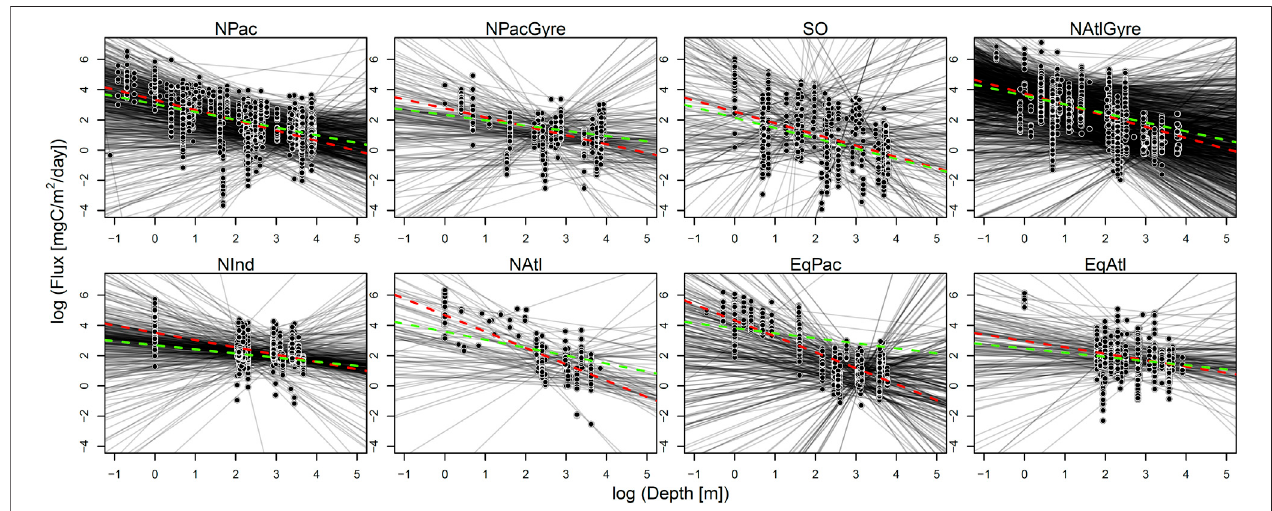
FIGURE 3 | Results from data-aggregation and parameter-aggregation fi ts. For each biome, an individually fi tted pro fi le is shown in shaded black lines. The green dotted line is the parameter-aggregation fi t (i.e., the uncertainty-weighted average of individual lines). The red dotted line is the fi t for the data-aggregation method.